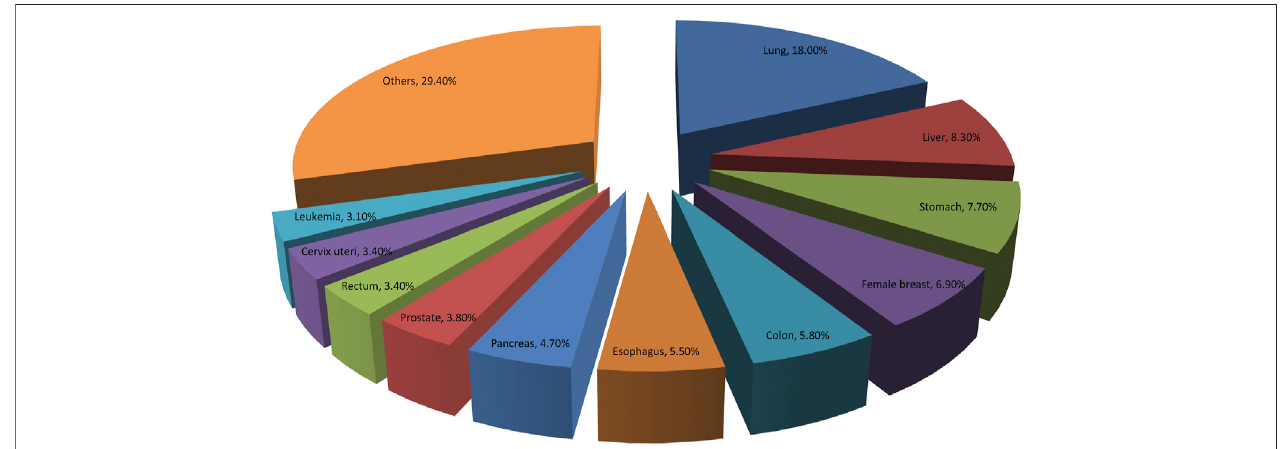
FIGURE3| Distributionoftop10deathsofCancersaccordingtotheGLOBOCAN2020.Lungcancerremainsthemostcommoncauseofcancerrelated-mortality all over the world.